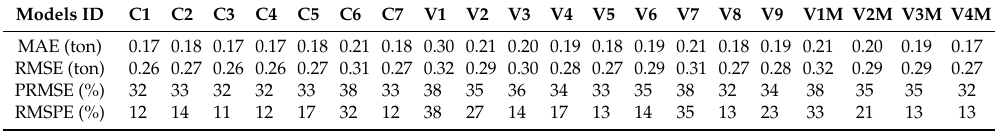
Table 3. Tree-level accuracy statistics of the volume-based and biomass-based AGC